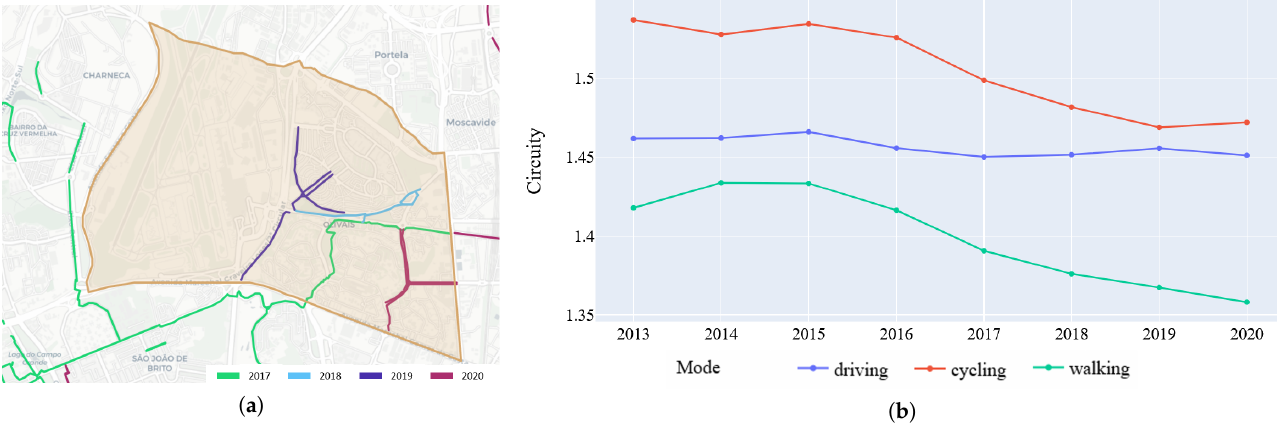
Figure 9. Cycling infrastructure changes from 2017 to 2020 in Lisbon’s parish of Olivais ( a ), and the evolution of the median circuity in Olivais ( b